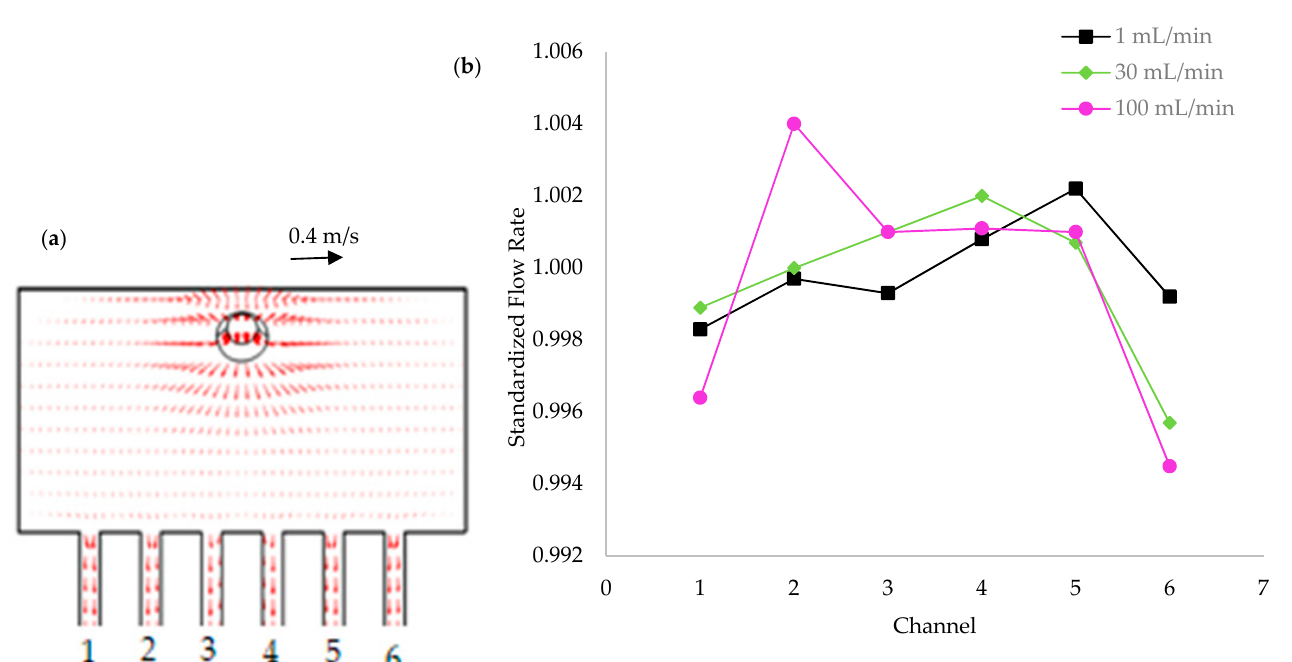
Figure 14. FDU study for the vertical configuration. ( a ) Schematic view of the velocity profile for a 100 mL/min flow and at a scale of 2. ( b ) The standardized flow in each channel of the heat sink. As the vertical configuration has the best flow distribution, an attempt was made to improve it by changing the collector geometry from rectangular to triangular or circular.